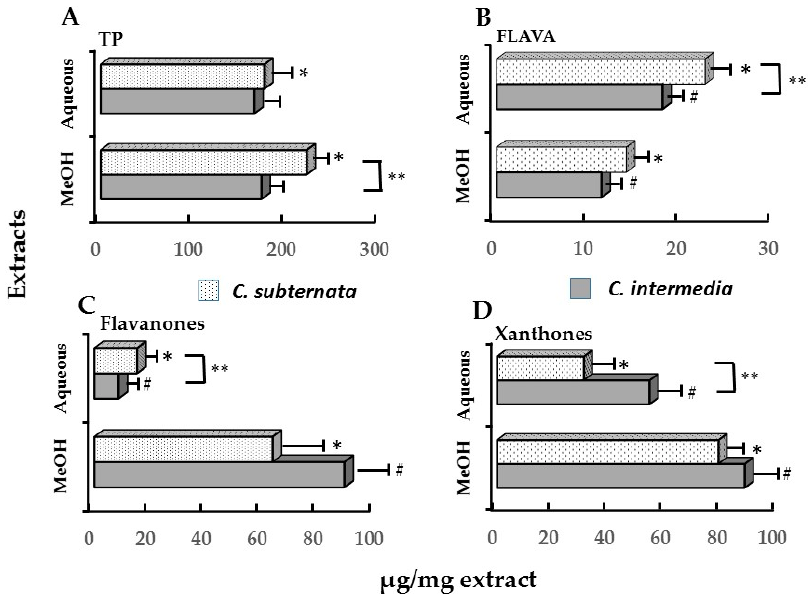
Figure 2. Quantitative levels of: ( A ) TP (total polyphenol); ( B ) FLAVA (flavanol/proanthocyanidin); ( C ) flavanone (hesperidin, eriocitrin and eriodictyol-glycoside); and ( D ) xanthones (mangiferin and isomangiferin) content of the methanol (MeOH) and aqueous (Aq) extracts of C. subternata and C. intermedia. Values represent means of triplicate determinations. * , # Means of methanol and aqueous extracts of a Cyclopia species differ significantly ( p < 0.05). ** Significant ( p < 0.05) species differences. Data derived from [24].